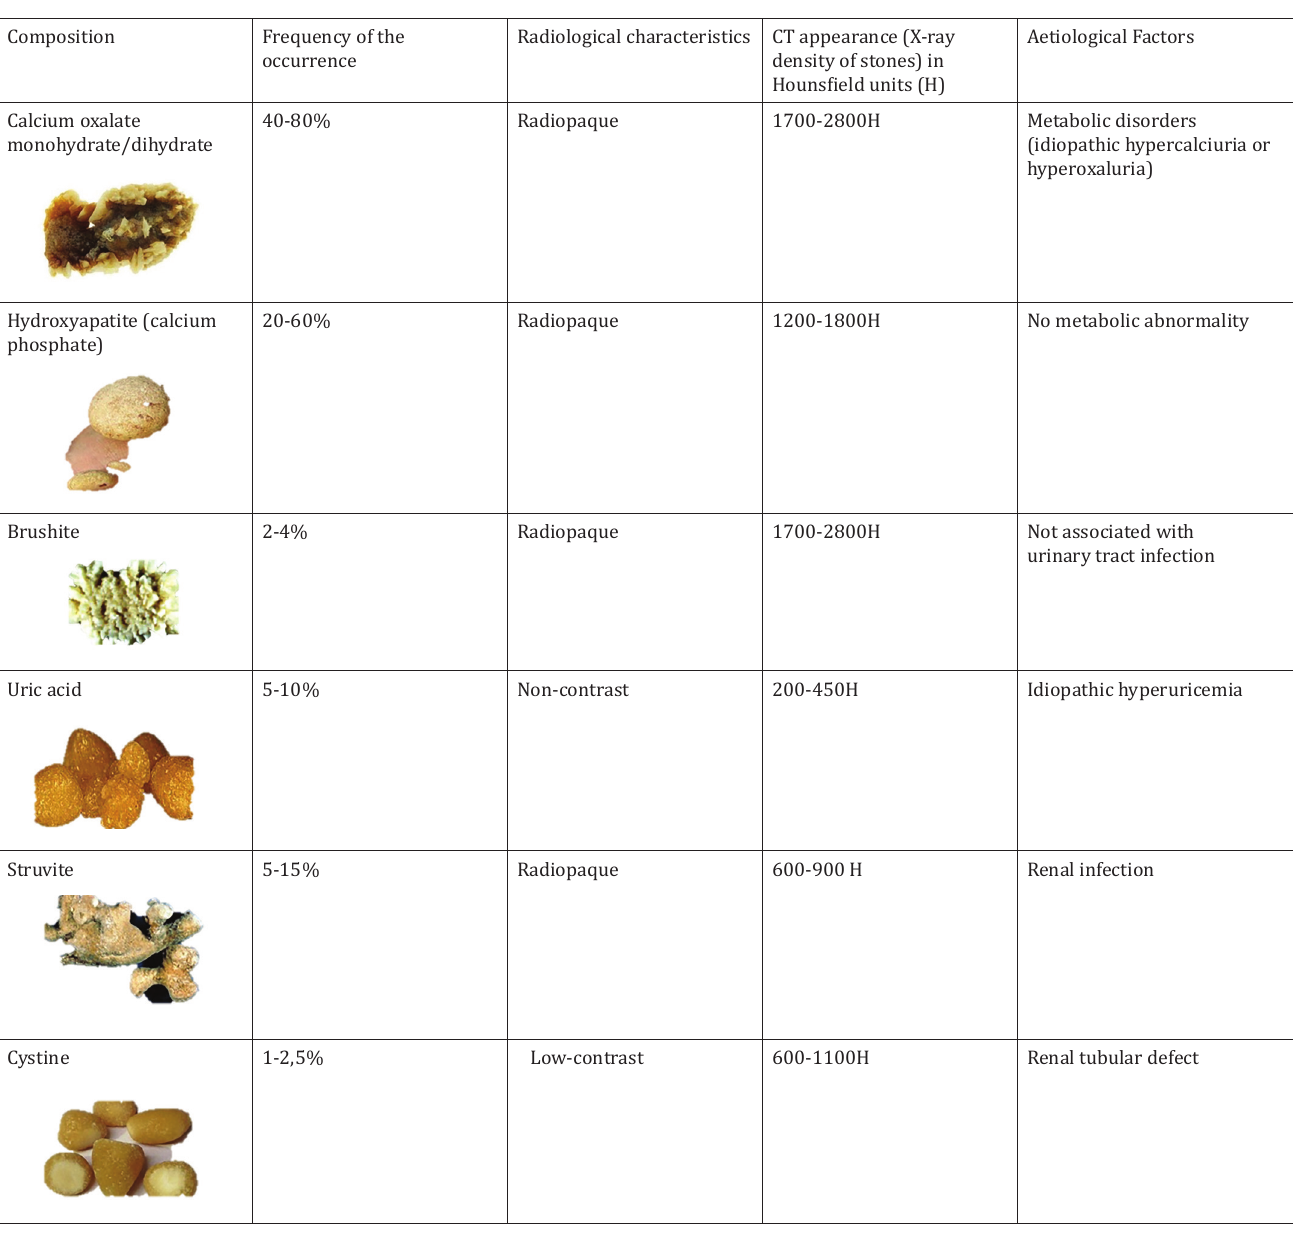
Table 1 The characteristic features of the most common urinary tract stones